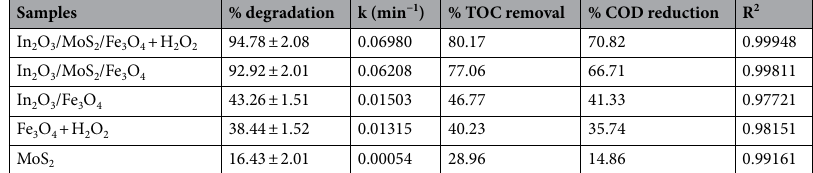
Table 6. Photodegradation chart of esomeprazole over various catalysts.